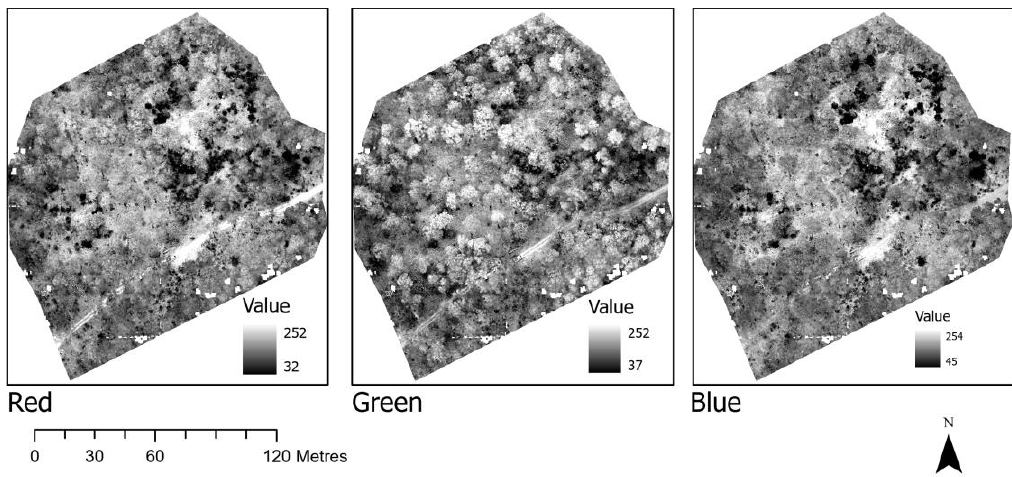
Figure 3. Location of the first site selected for analysing drone data and the orthomosaic of the site.